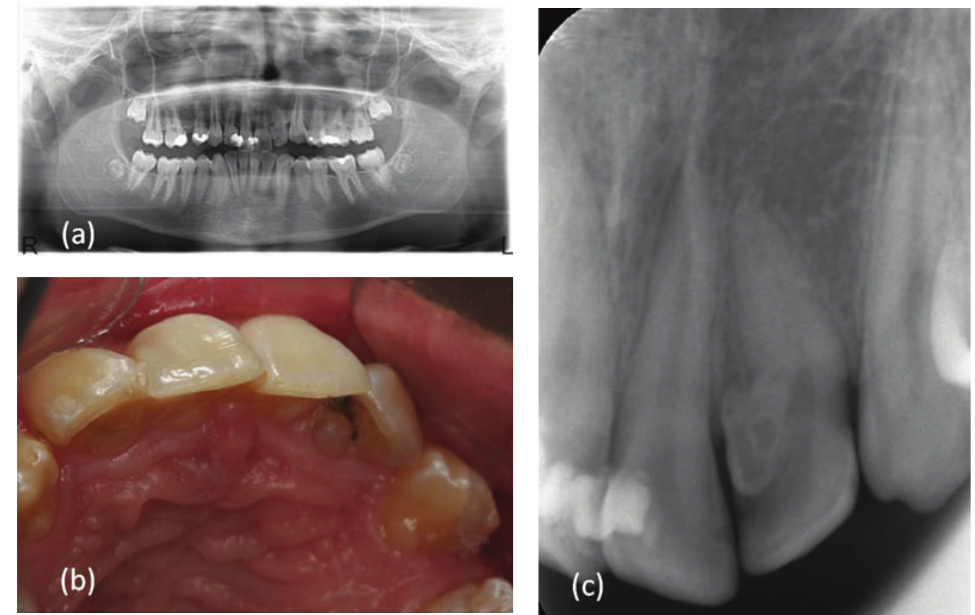
Figure 1: (a) Preoperative panoramic radiograph, (b) preoperative photograph: palatinal view, and (c) preoperative radiograph revealing the maxillary left lateral incisor with an unusual anatomy.